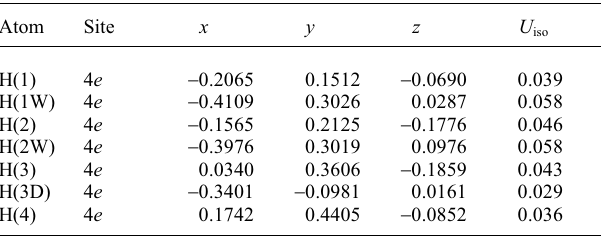
Table 2. Atomic coordinates and displacement parameters (in Å 2 ) .